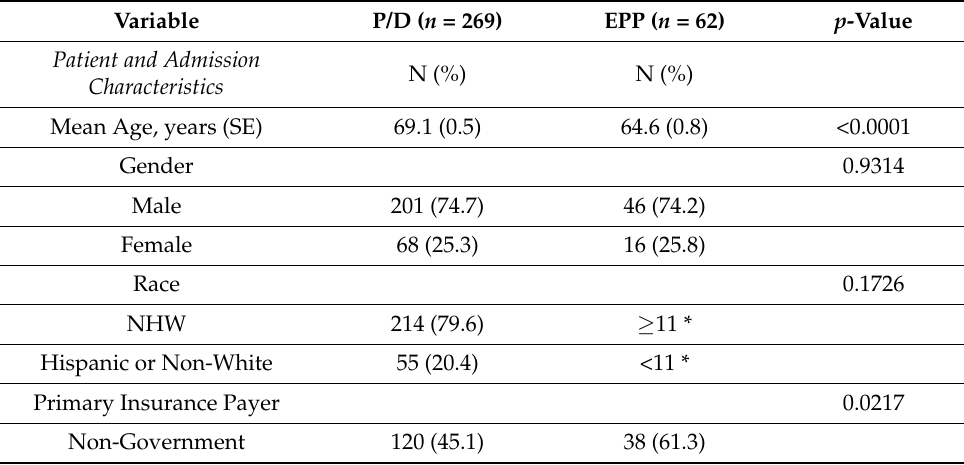
Table 1. Demographics of the sample, according to surgery